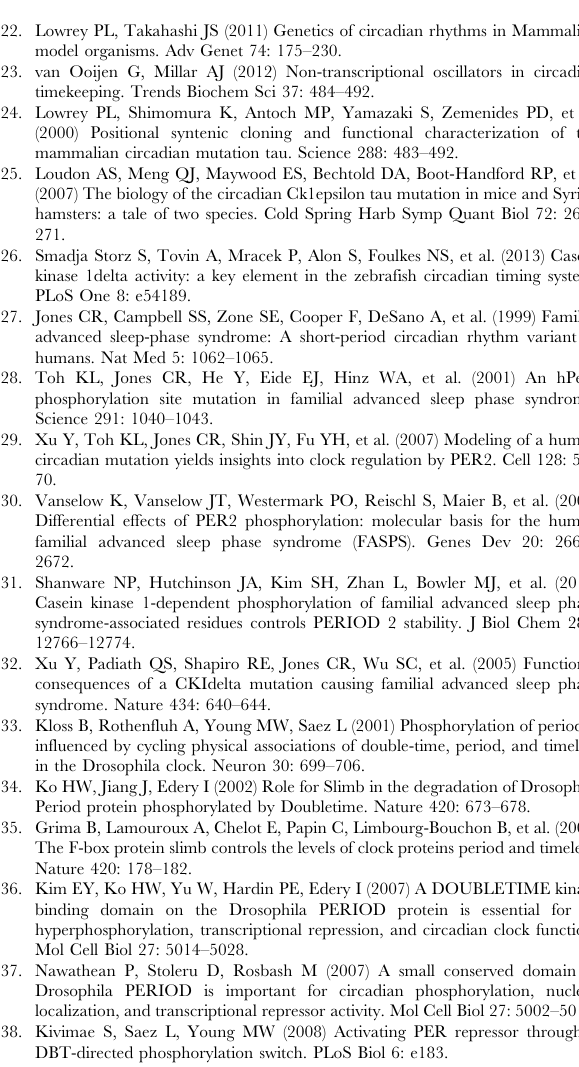
isoform. Red arrow: novel short DBT isoform. Arrow head: high molecular weight DBT-immunoreactive bands. *: a non-specific band serving as a loading control. Molecular weight standards (in KD) are shown on the left side of the image. Figure S7 Western blot showing that LARK overexpression does not induce the smaller isoform at pupal stage. OE: overexpression. OC: control for overexpression. Time of sample collections are indicated. Overexpression of LARK was achieved by driving uas-lark with elav-gal4 . Samples extracted from whole pupae are on the left (lanes 1–4), sample extracted from adult heads (as a positive control) are on the right (lanes 6–7). Lane 5: molecular weight ladder. Black arrow: known DBT isoform. Red arrow: novel short DBT isoform (only seen in adult head OE sample). Upper and lower panels show the same blot with different exposure times. Exposure time in the lower panel was reduced to allow a clear view of the novel short DBT isoform in the adult OE sample. Table S1 Period and Rythmicity Index (RI) for all characterized genotypes. Abbreviated labels are the same as those used in